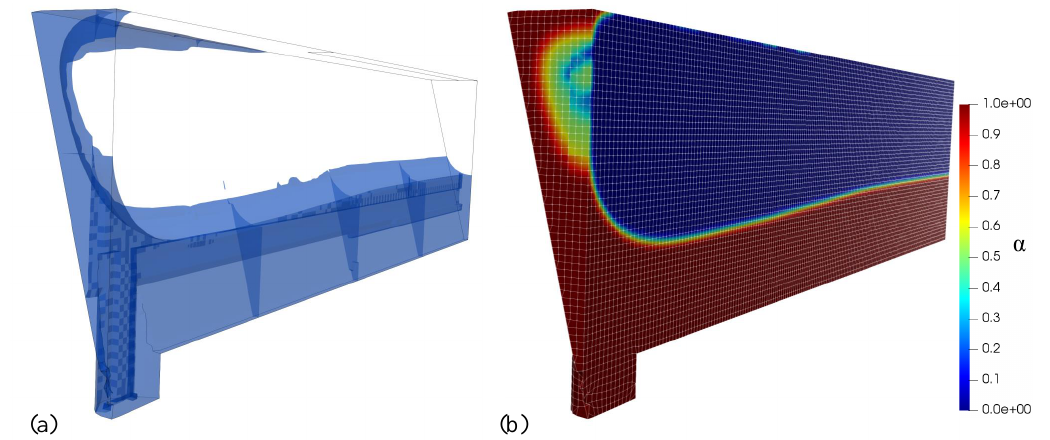
Figure 9. ICF-1 computational domain showing ( a ) liquid volume as phase fraction α < 0.6 and ( b ) phase fraction α interpolated throughout each computational cell (outlined in